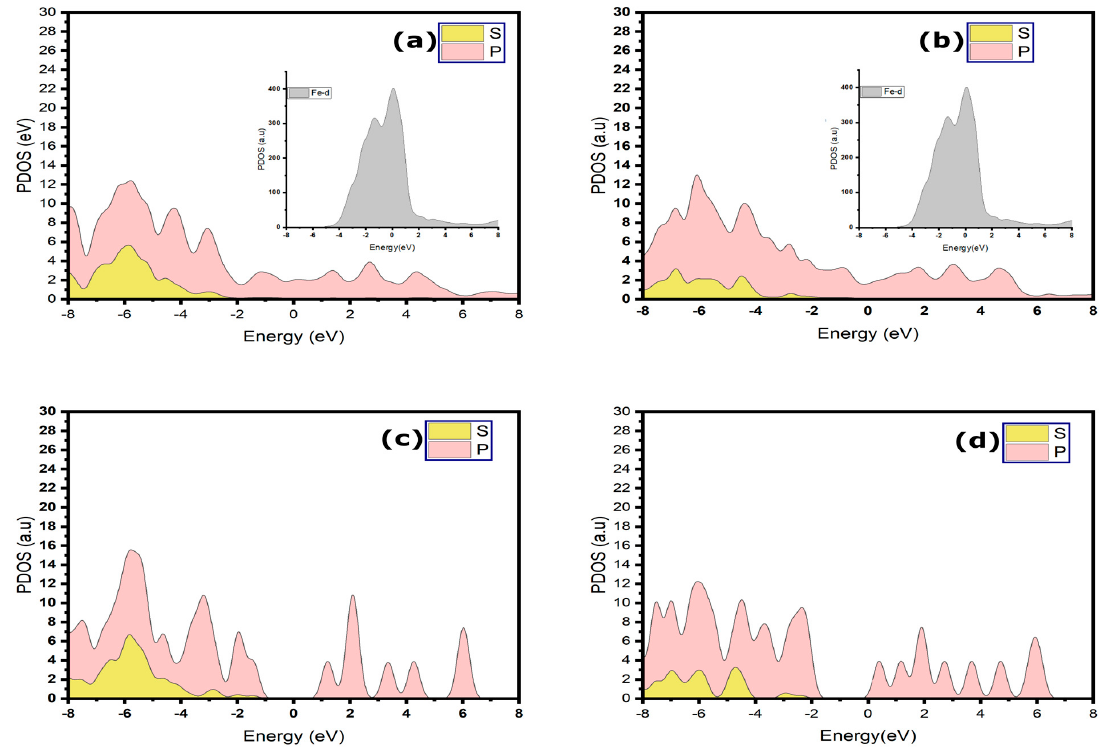
Figure 9. PDOS for ( a ) MAPEI, and ( b ) OHEI molecules adsorbed on Fe(110) surface and the Fe atoms beneath them (inset). ( c , d ) Isolated inhibitor molecules 7 Å above iron.